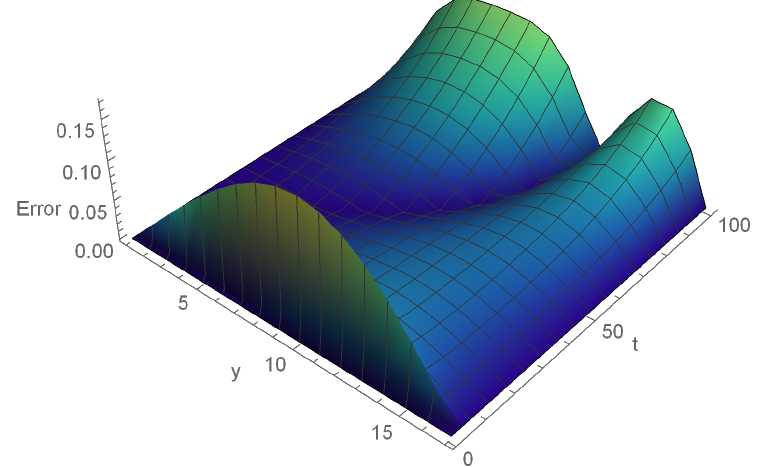
Figure 5 . Error graph of Example 2 for α = 0.15, N = 16 at T =